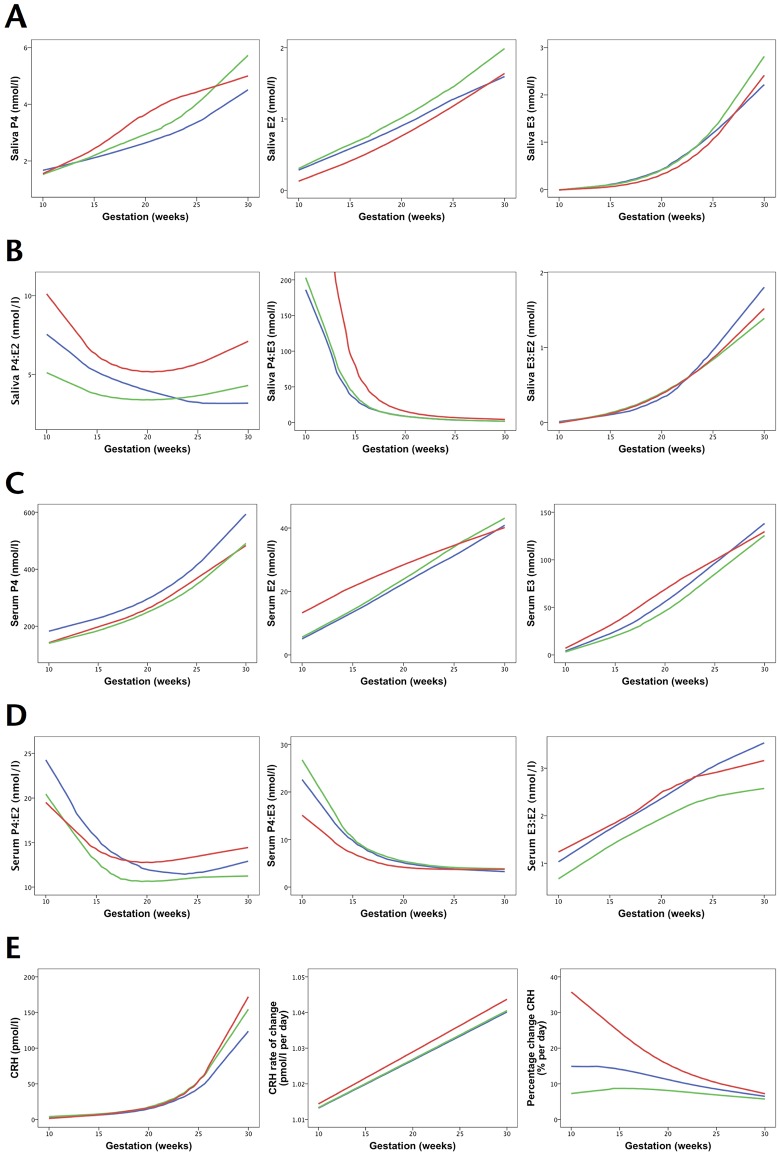
Hormone trajectories (smoothed median curves) in early preterm (n = 8), preterm (n = 40) and term (n = 50) groups.Red lines, <34 weeks at delivery; green lines, 34-<37 weeks; blue lines, 37+ weeks. (A) Salivary concentrations (n = 7, 35, 43 for <34, 34-<37 and 37+ weeks respectively). (B) Salivary ratios. (C) Serum concentrations (n = 8, 41, 43 for <34, 34-<37, 37+ weeks respectively). (D) Serum ratios. (E) CRH concentrations and derived variables.